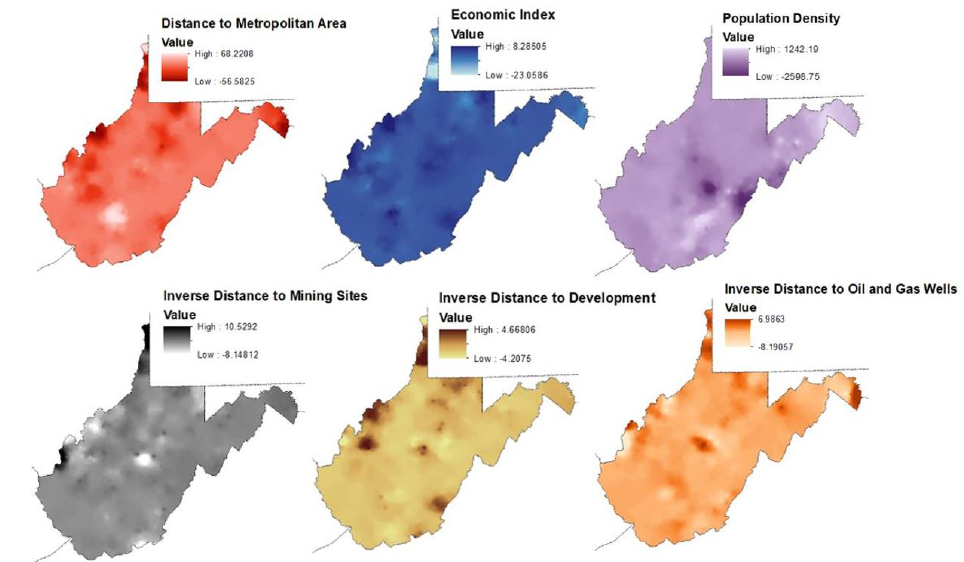
Figure 12. Geographic Coefficients for the 2005 −